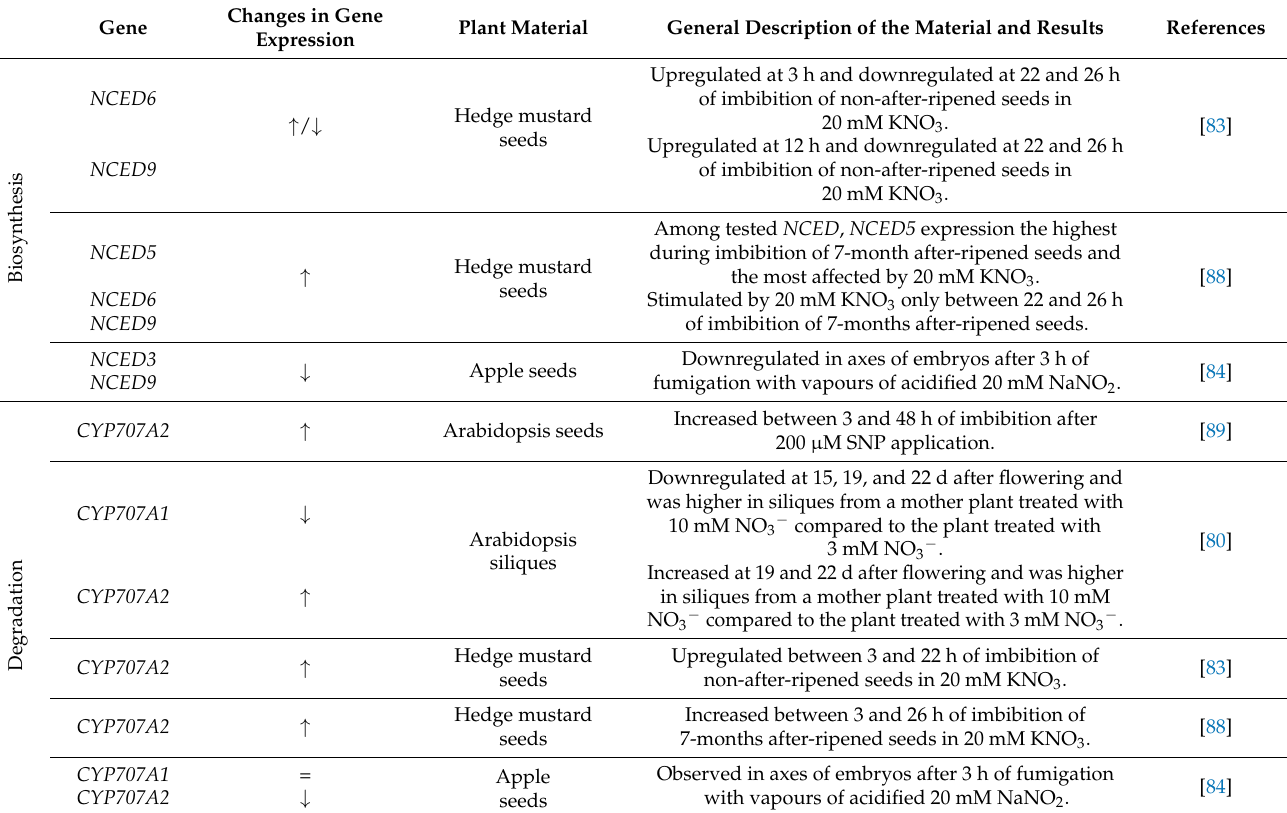
Table 2. NO-dependent changes in the expression of genes related to ABA metabolism and signalling in seeds or